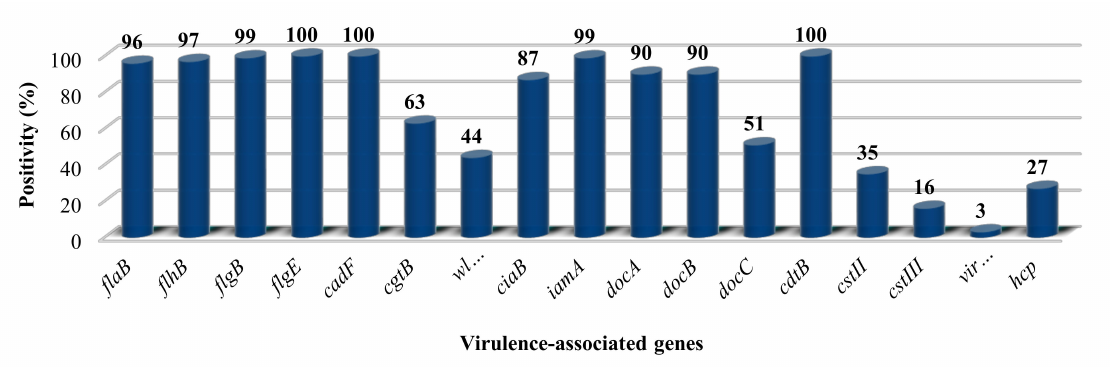
Figure 1. Percentage distribution of 14 previously described putative virulence genes in 190 C. jejuni isolates. (See details in Supplementary Table